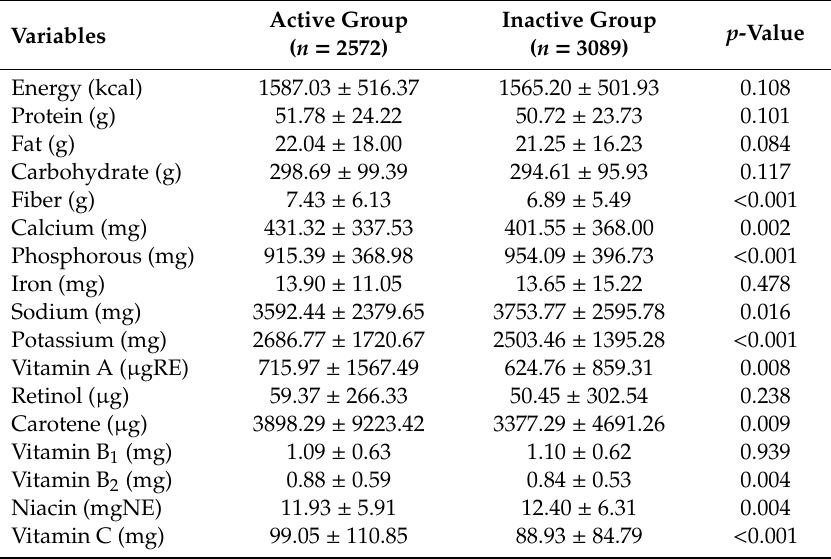
Table 4. Nutrient intakes according to physical activity.